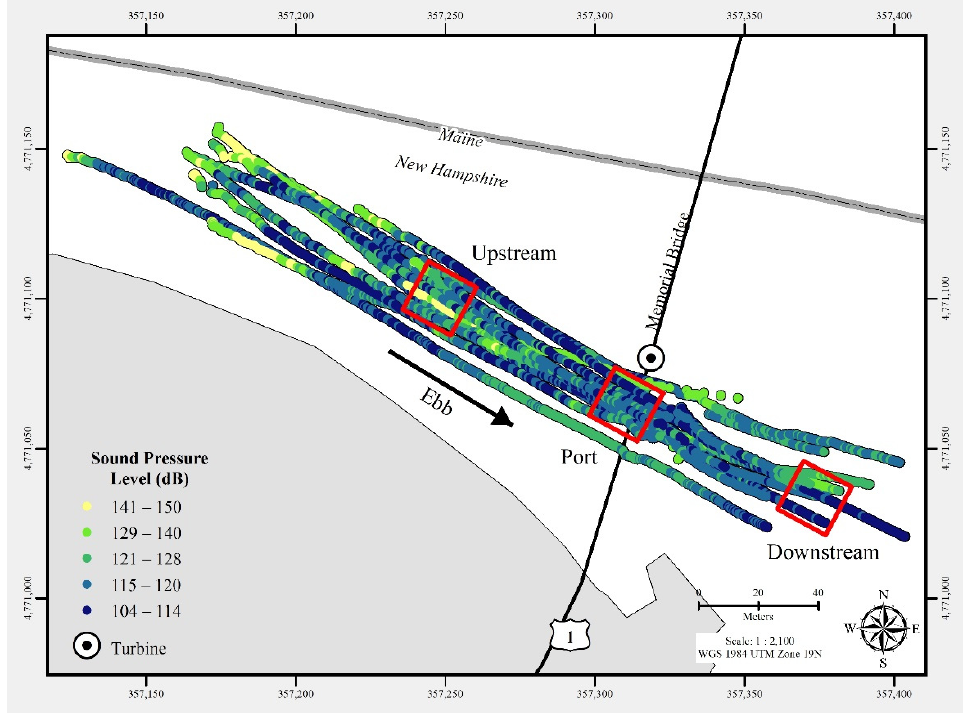
Figure 9. Sound pressure levels along 14 drifting tracks. Note the three 25 m × 25 m zones centered roughly 100 m upstream and downstream of the turbine, and the zone centered 25 m to port where the sound metrics were calculated.